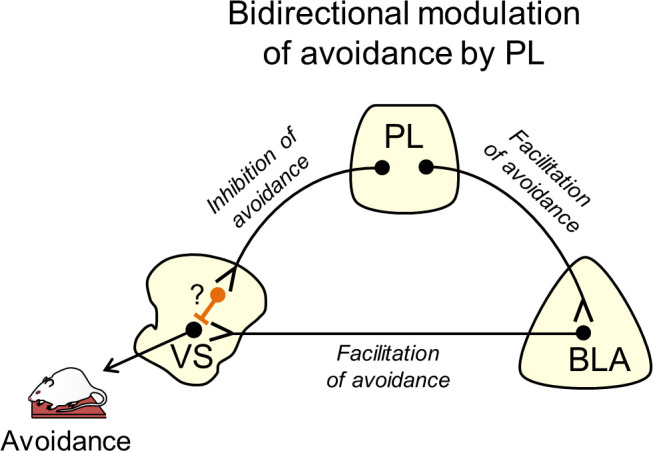
Suggested circuit for bidirectional modulation of avoidance by PL.Activity in PL projections to VS decreases avoidance (top left projection). These projections may target fast-spiking interneurons within VS (orange neuron with question mark), which serve to inhibit VS output neurons. Activity in PL projections to BLA increases avoidance (top right projection), as do BLA projections to VS (bottom projection). In this way, PL inputs to VS could gate the impact of BLA inputs on VS output neurons.